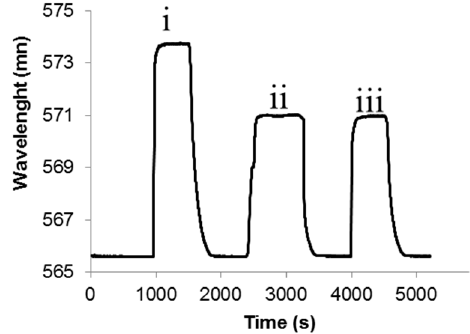
Figure 12. Sensogram (nm vs. time) of BICELL 1: Comparison of signal provided by (i) a 20% NaCl solution; (ii) a mixture of 20% NaCl and 0% NaCl in the micro-mixer (i.e., 10% NaCl solution); and (iii) a 10% NaCl solution.